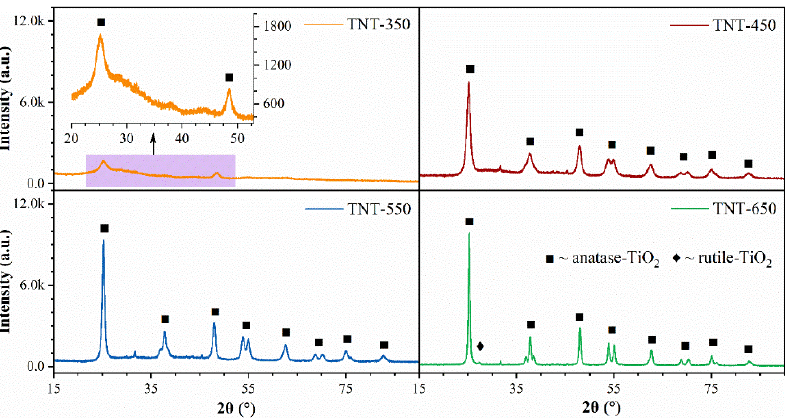
Figure 4. XRD spectra of the nanostructured photocatalysts.